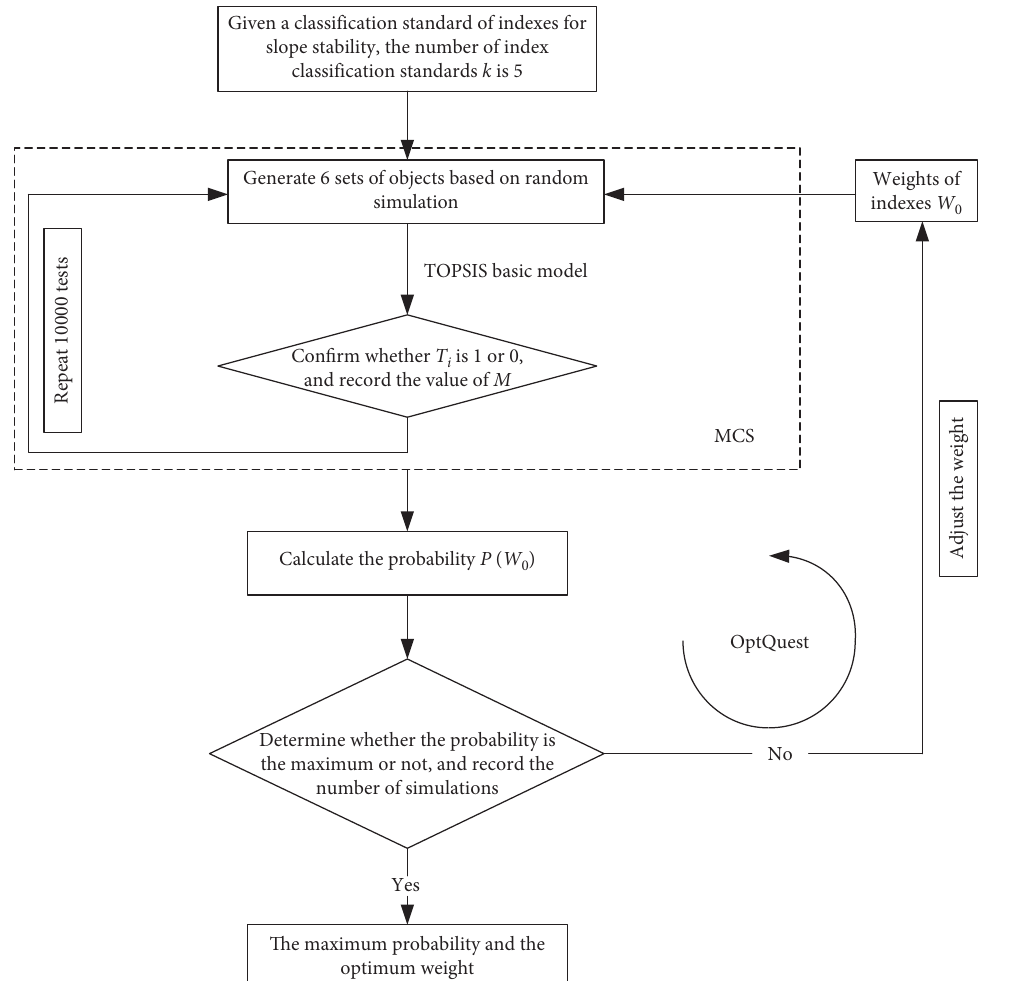
Figure 1: Basic flow chart of TOPSIS-MCS coupled model for calculating the weight W .